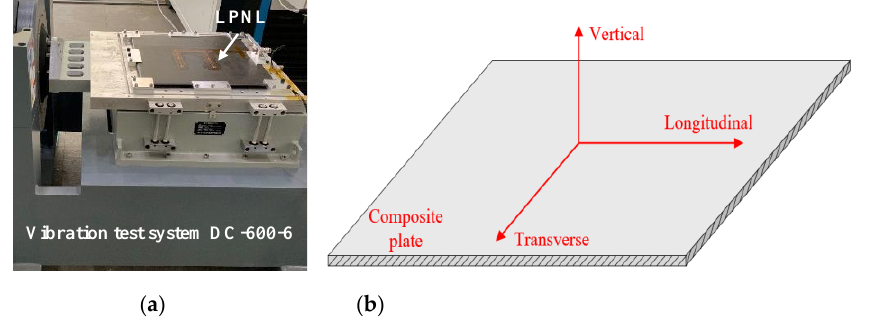
Figure 10. Experimental setup of vibration test. ( a ) Experimental setup. ( b ) Definition of vibration direction.